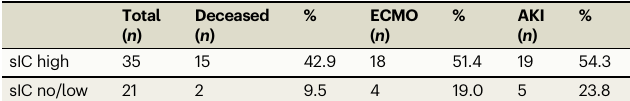
Table 2 | Clinical characteristics associated with